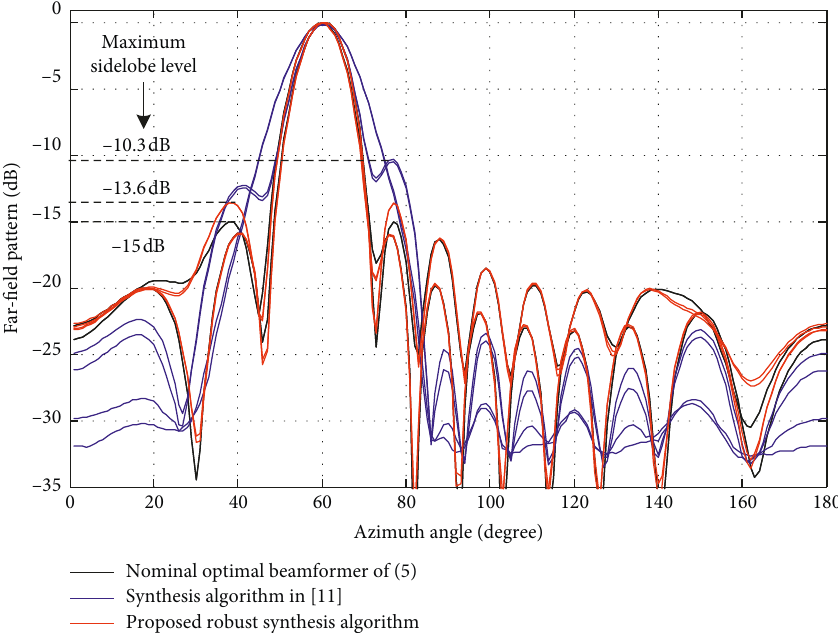
Figure 4: Far-field patterns of different synthesis algorithms for the DM signal.